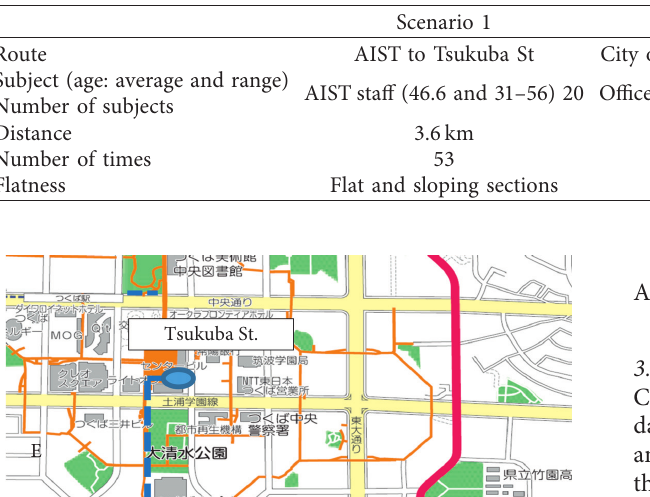
Table 2: Features of each scenario.